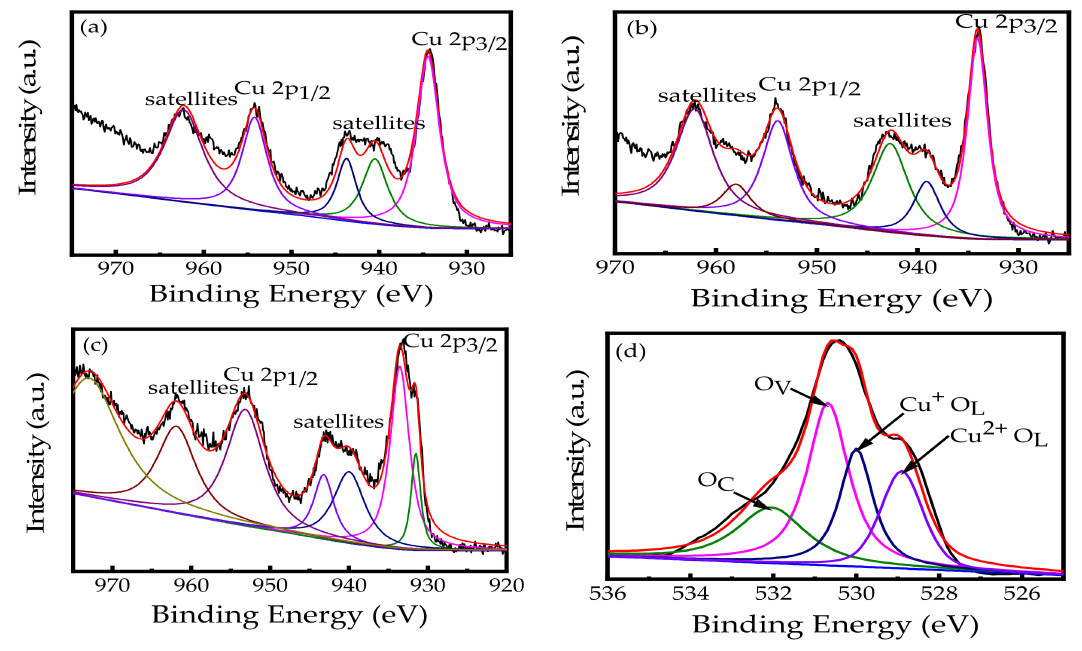
Figure 3. XPS spectra of Cu-MOF ( a ), Cu-MOF-urea ( b ) and CuxO/MOF ( c ) in the Cu region, and ( d ) O 1s of Cu x